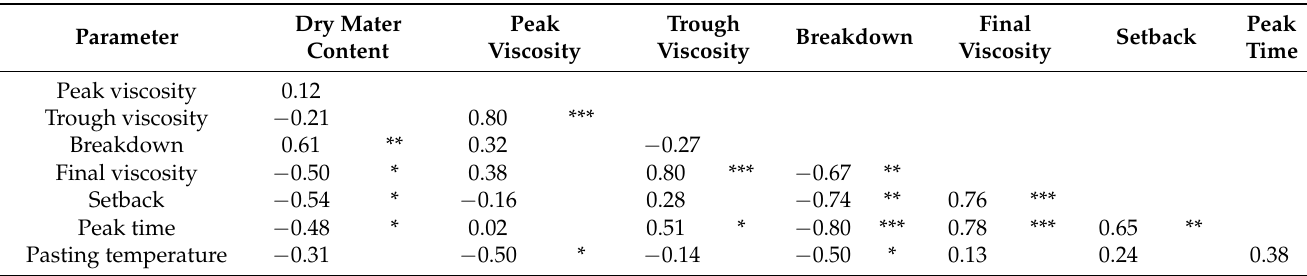
Table 5. Correlation Analysis of dry matter content and starch pasting properties by using Best linear unbiased prediction (BLUP) value in twenty Dioscorea rotundata genotypes grown at three different locations in Nigeria. Dry Parameter